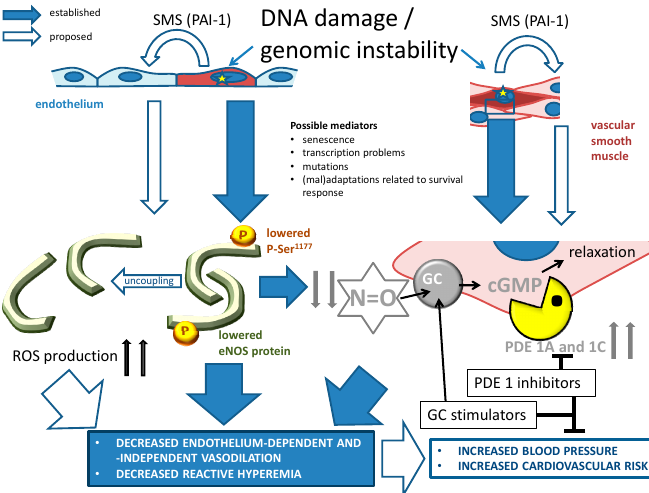
Figure 3. The role of genomic instability (indicated by yellow stars) on NO-cGMP signaling, and its consequences for age-related cardiovascular disease. Large, blue closed arrows indicate established relationships: genomic instability primarily leads to endothelial eNOS dysfunction in endothelial cells and to increased cGMP metabolism by PDE1A and 1C (Section 4.5.1). Large, blue open arrows refer to proposed mechanisms that were not fully explored: cellular senescence caused by unrepaired DNA could affect healthy cells through SASP/SMS, in which PAI-1 potentially plays a central role (Sections 3.4.1 and 5.2.2.). The affected cells in turn might worsen vascular function through changes in eNOS-cGMP signaling. PDE1 subtype inhibitors and guanylyl cyclase (GC) stimulators are promising drugs to at least acutely improve vascular function. Their value for prevention of genomic instability and vascular aging needs to be assessed. PDE1A and 1C have a putative role in atherosclerosis, arteriosclerosis, reduced blood flow and hypertension (see Sections 4.5.1 and 5.4). Their expression is strongly related to cellular senescence, and genetic variables of the PDE1A gene affect blood pressure and vascular hypertrophy (Section 4.5.1). Thus, both PDE1 subtypes appear to be central in vascular aging-related disease. Small, thick arrows pointing up or down indicate up- and down-regulation respectively. Blunt arrows indicate inhibition, pointed thine arrow indicate stimulation.